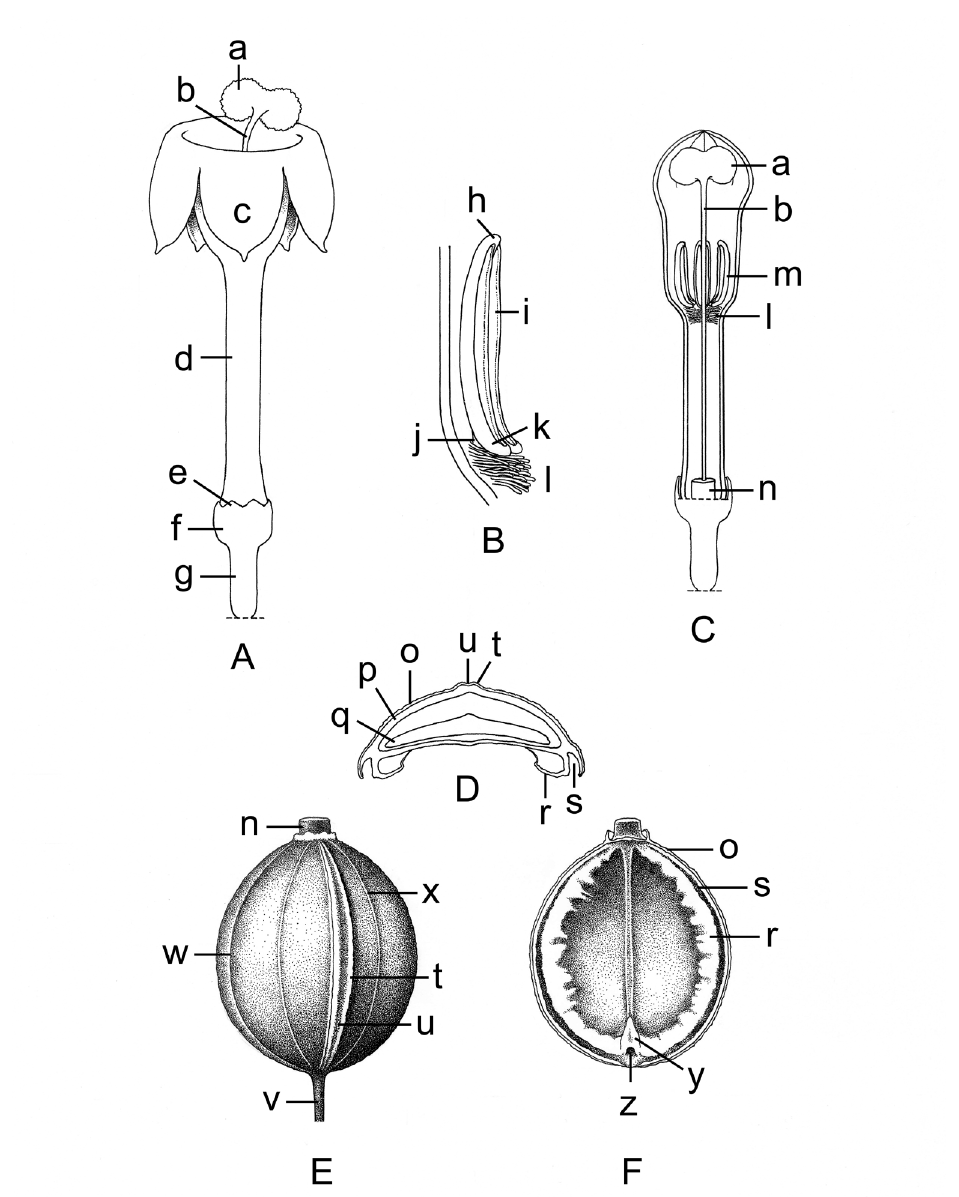
Fig. 3. Morphological glossary of Chassalia Comm. ex Poir. in Borneo; A–C, E–F = C. involucrata T.Y.Yu sp. nov.; D = C. chewii T.Y.Yu sp. nov. A . Flower. B . Part of flower showing stamen insertion into corolla and associated hairs. C . Longitudinal view of corolla showing the inflated turbinate distal portion of the corolla in bud. D . Pyrene transection. E . Dry fruit. F . Pyrene ventral surface. a = stigma; b = style; c = corolla lobe reflexed; d = corolla tube; e = calyx lobes; f = calyx tube; g = hypanthium; h = apical connective appendage of anther; i = anther cell; j = filament, usually very short or absent; k = basal appendage of anther; l = band of hairs; m = stamen; n = disc, usually cylindrical; o = pericarp; p = endocarp; q = seed; r = endocarpal outgrowth; s = groove between endocarp margin and endocarpal outgrowth; t = longitudinal crests of pyrene ventral surface; u = groove between two longitudinal crests; v = pedicel, usually absent in flower and extending as fruits mature; w = furrow where the two pyrenes meet; x = veins on the dorsal surface of pericarp; y = bony spine, usually at distal side of raphal opening; z = raphal opening, usually round. Drawn by T.Y.